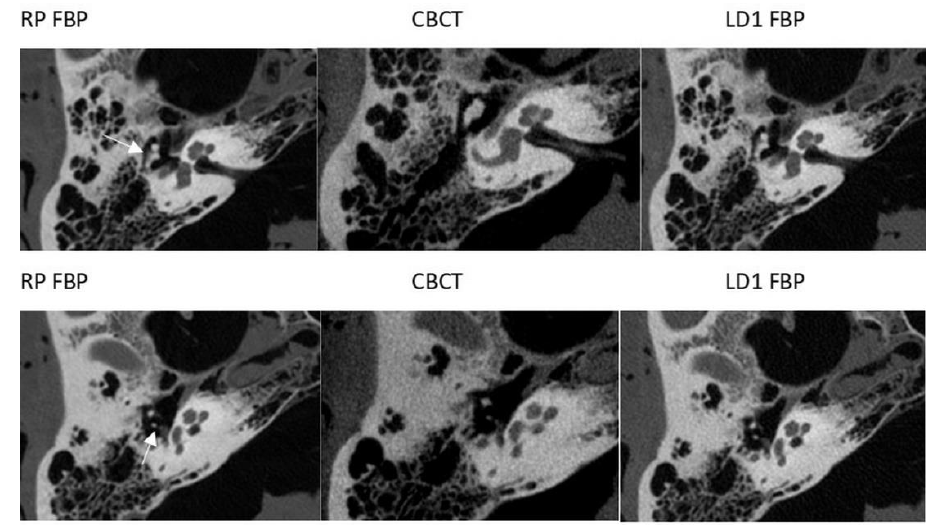
Figure 3. Visualization of the incudomalleolar joint (upper row) and incudostapedial joint (lower row) (white arrows). RP = reference protocol (83.72 mGy), FBP = filtered back projection, CBCT = cone-beam CT, LD1 = low dose 1 protocol (26.79 mGy).